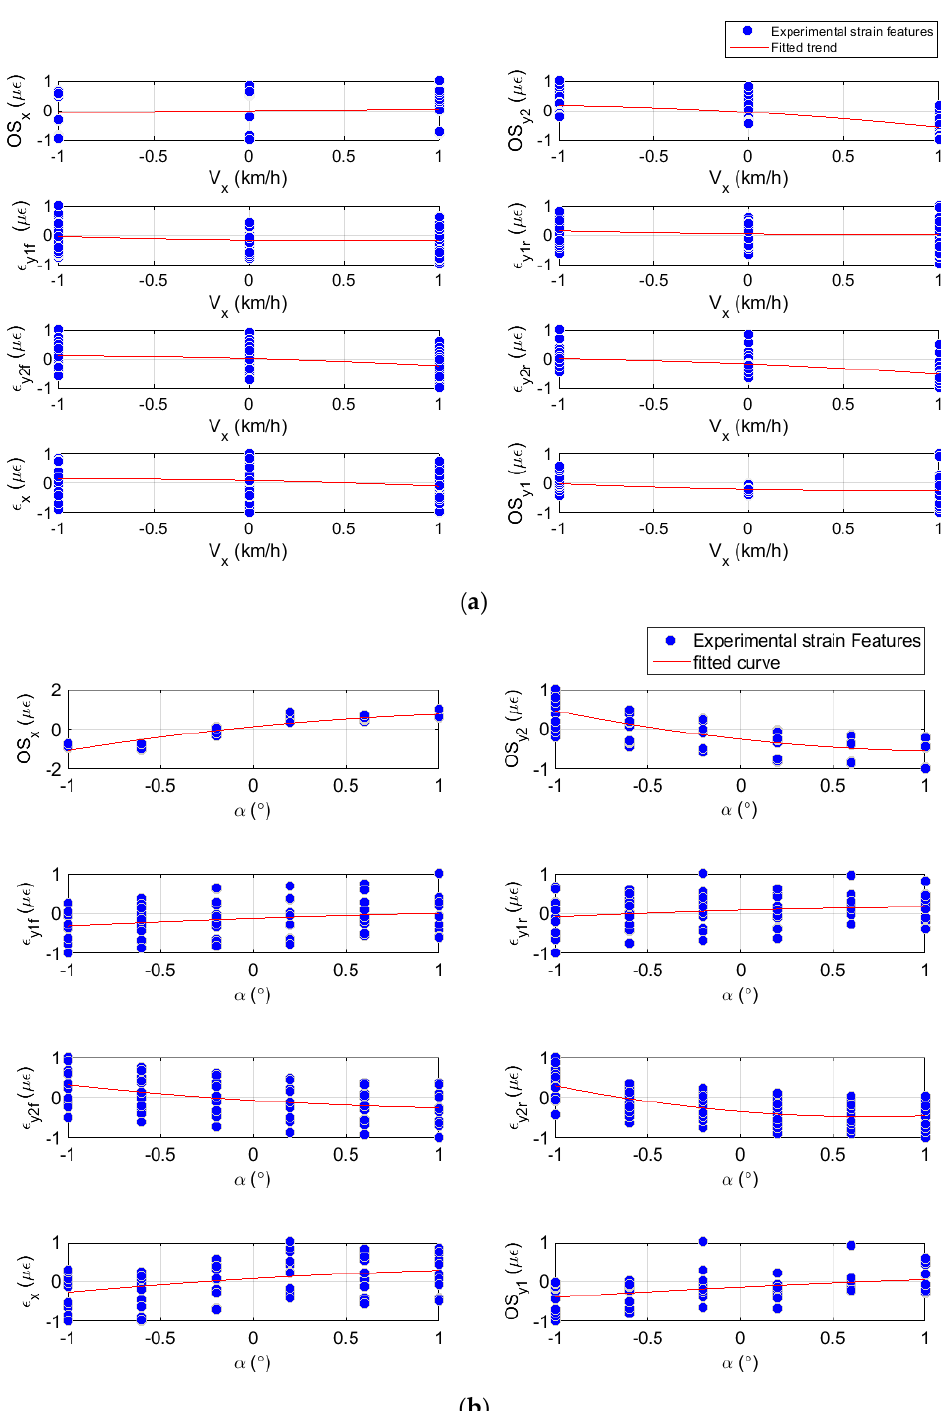
Figure 6. Simple curve fitting, variation of the strains features as function of potential parameters. ( a ) Strains feature as function of rolling speed. ( b ) Strains feature as function of slip angle